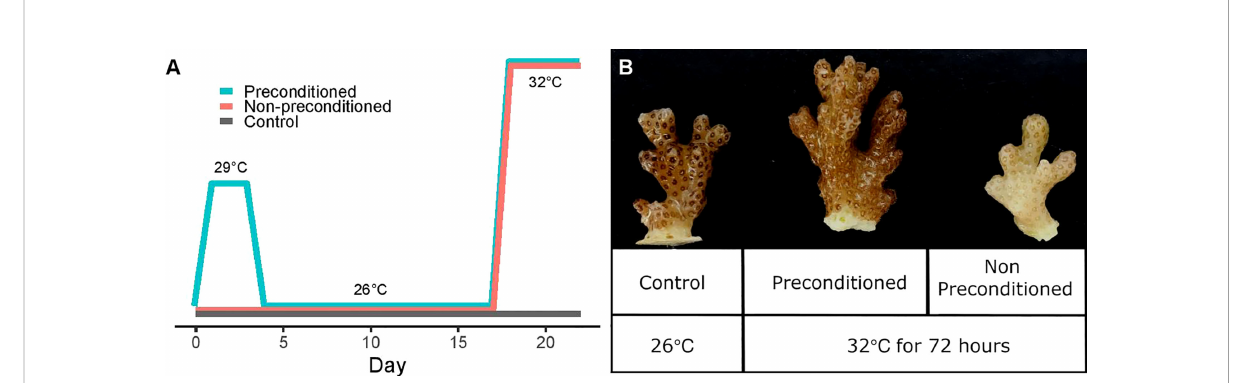
FIGURE 1 Experimental design. (A) Preconditioning pro fi le. Preconditioned corals (PC) were exposed to sublethal 29°C for 72 hours and returned to 26°C for additional two weeks before undergoing acute thermal stress (32°C). Non-preconditioned (NPC) corals were exposed to acute thermal stress with no previous preconditioning. (B) Different response to acute heat stress (32°C for 72 hours) in preconditioned (PC) and non- preconditioned (NPC) corals (right). While PC corals resembled control corals, NPC corals were visibly